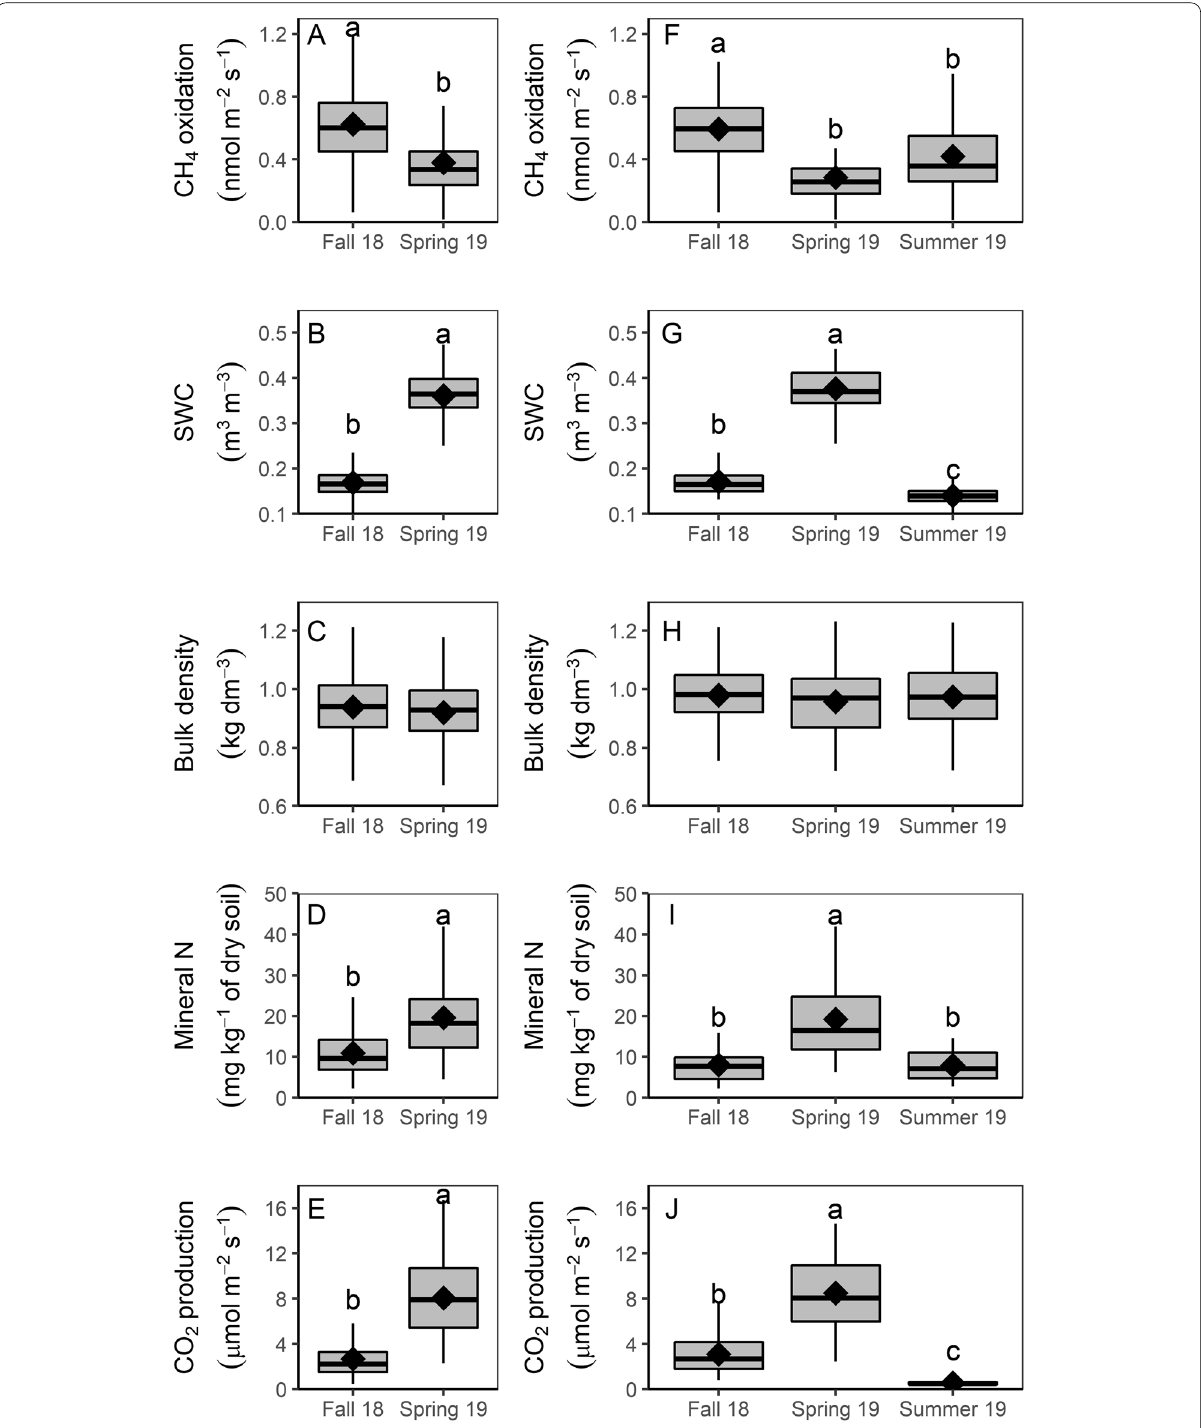
Fig. 2 Potential CH 4 oxidation ( A , F ), soil water content (SWC, B , G ), bulk density ( C , H ), mineral nitrogen ( D , I ) and CO 2 production ( E , J ) of intact soil cores (0–5 cm in depth) incubated at 20°C. The box plots include values of 12 samples in 13 stands ( n 156) in fall 2018 and spring 2019 (left part = of the figure: A – E ) and values of 12 samples in five stands ( n 60) for the three sampling dates (right part of the figure: F – J ). The horizontal thick = line is the median; the diamond, the mean; the box, the interquartile range; the whisker, from the largest value no further than 1.5 times the upper quartile to the smallest value at most 1.5 times the lower quartile. Outliers (1 to 3 values) are not plotted to not extend the y -axis scale. Different letters indicate significant differences at p 0.05 between =